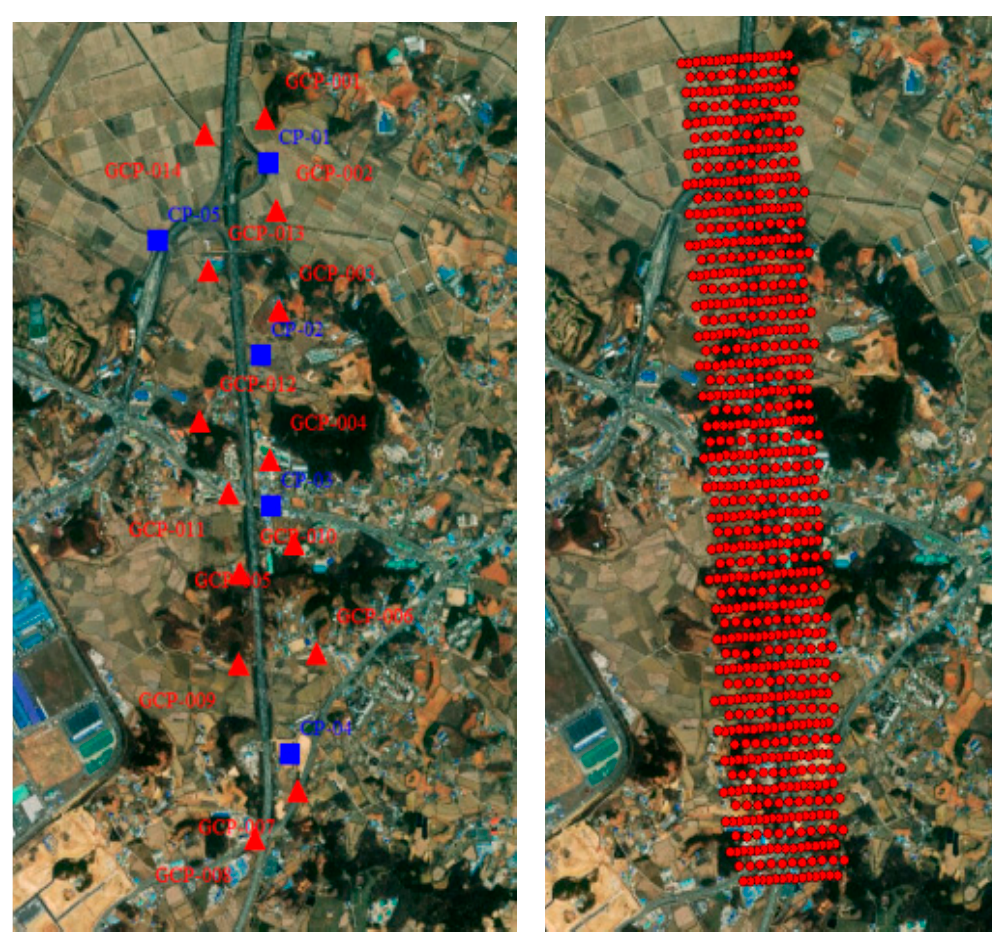
Figure 4. ( left ) Ground control points (GCPs), represented by the red triangles, and check points (CPs), represented by the blue squares, ( right ) image acquisition position.